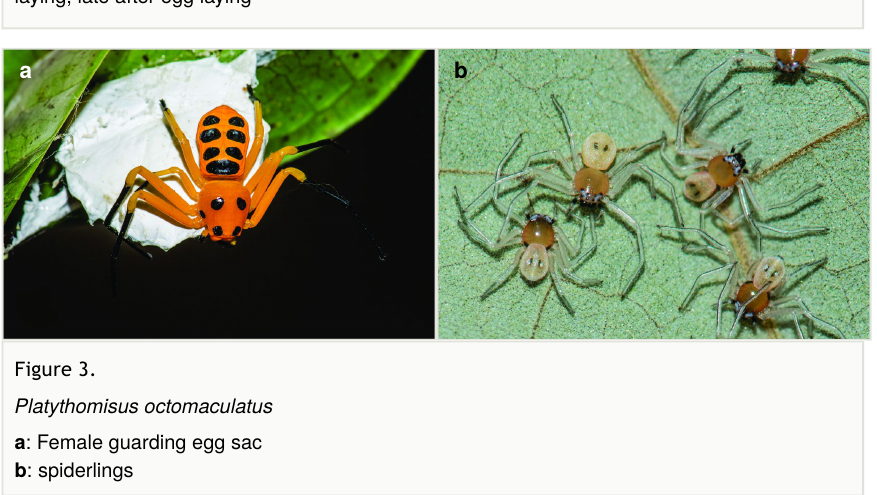
Figure 3. Platythomisus